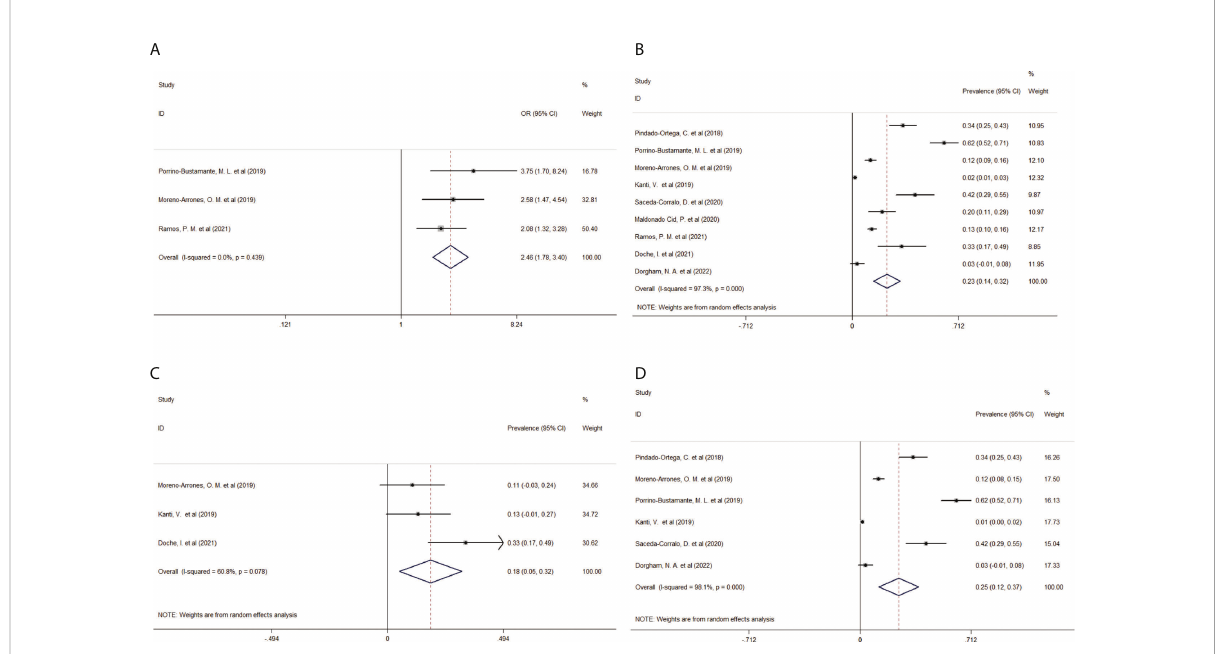
FIGURE 2 Forest plot of (A) the odds ratio of rosacea in patients with FFA, (B) pooled prevalence of rosacea in patients with FFA, (C) pooled prevalence of rosacea in male patients with FFA, and (D) pooled prevalence of rosacea in female patients with FFA. FFA, frontal fi brosing alopecia; OR, odds ratio; CI, con fi dence